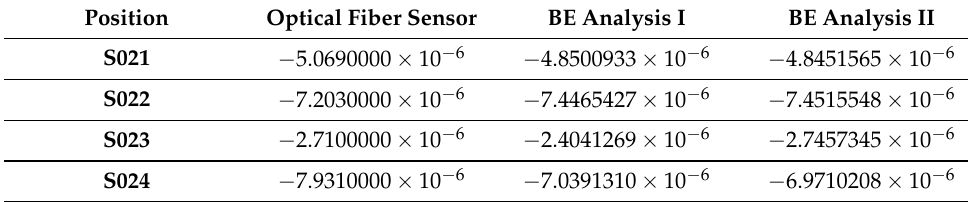
Table 3. Strain component (cid:101) xx